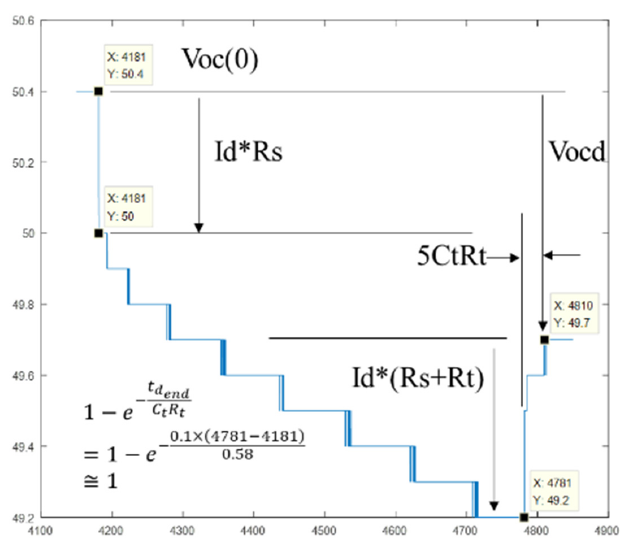
Figure 9. An offline numerical model based on the schematic method [16] (Id: discharge current; td: discharge time).